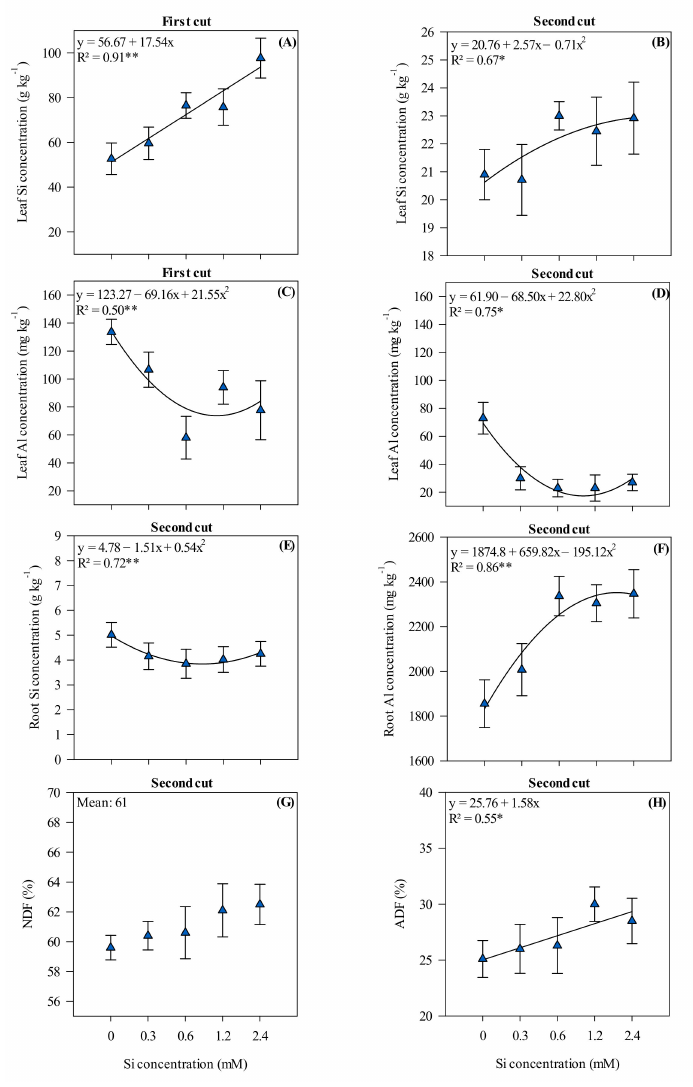
Figure 2. Leaf Si concentration in the first ( A ) and second cut ( B ), leaf Al concentration in the first ( C ) and second cut ( D ), root Si concentration ( E ) and root Al concentration ( F ) in the second cut, neutral detergent fiber (NDF) ( G ) and acid detergent fiber (ADF) ( H ) in the second cut as a function of increasing Si concentrations in Xara é s palisadegrass. Error bars indicate the standard deviation of the mean ( n = 4). * and ** = significant at 5 and 1% probability by F test